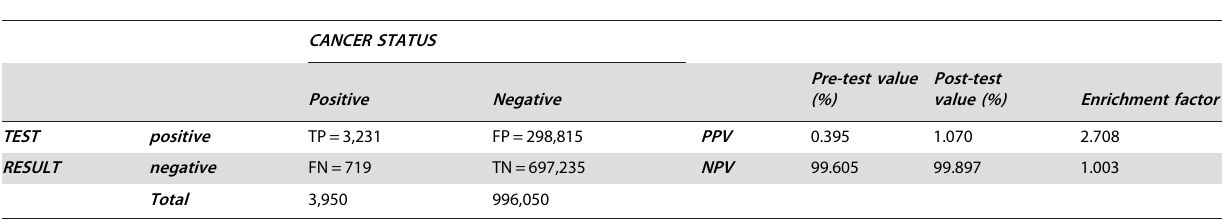
Table 2. Expected outcome of screening for breast cancer with breath test.